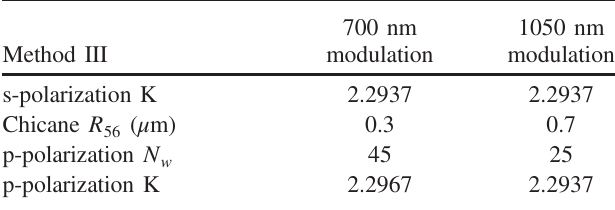
TABLE I. Genesis simulation parameters.